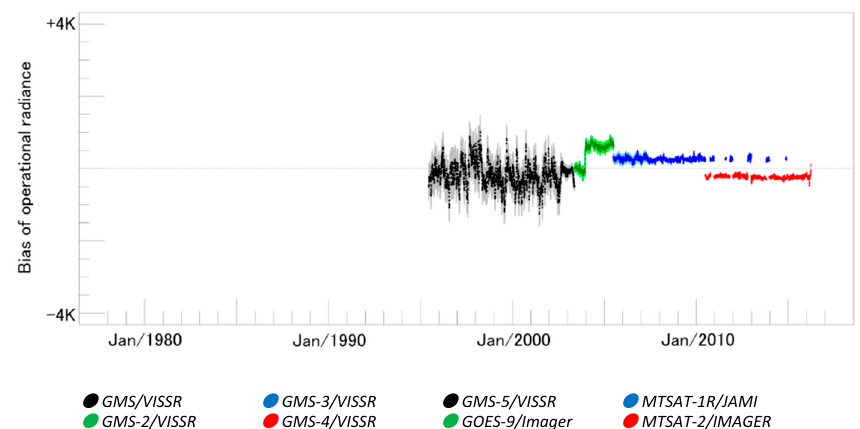
Figure 9. Time series of biases at standard radiance (after prime reference correction) for operational radiances against corrected radiances. For convenience the biases are presented as brightness temperatures. The shaded areas represent the uncertainties (1 σ ) of the biases.